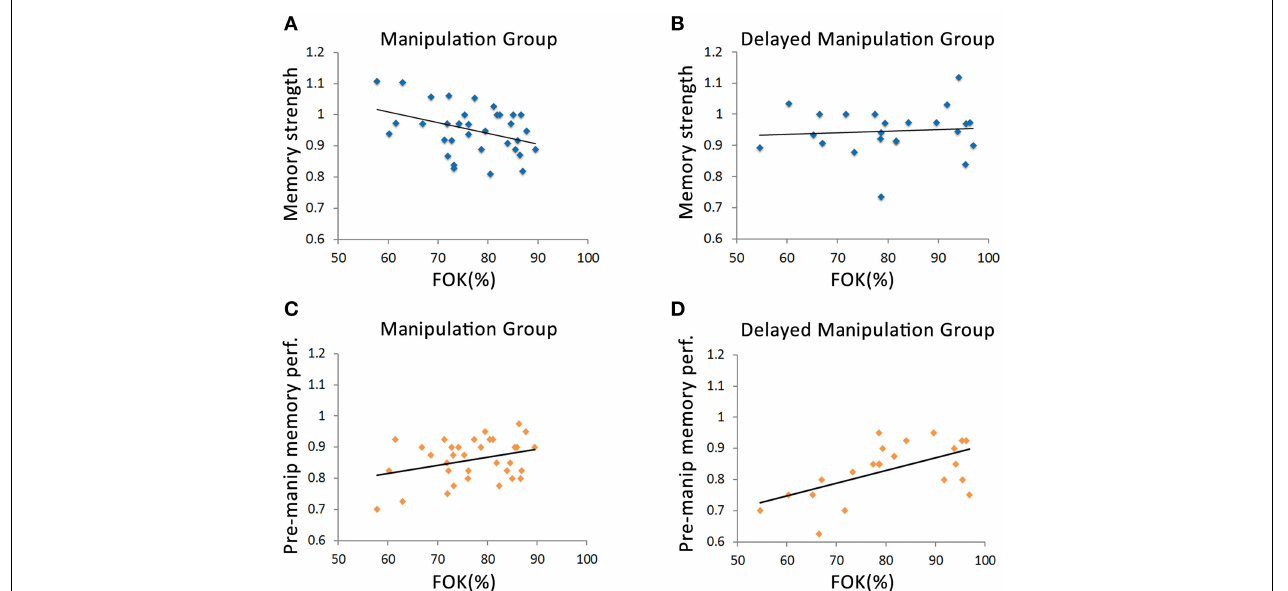
FIGURE 3 | Inter-participant correlations between FOK and Memory performance. (A) Scatterplot of memory strength vs. FOK for Manipulation Group, where movie 2 was learned immediately after reactivation of movie 1. The plot indicates a negative correlation between FOK and memory strength ( r = − 0 . 38, p < 0 . 05). (B) Scatterplot of memory strength vs. FOK for the Delayed Manipulation Group, for which movie 2 was learned 1 day after reactivation of movie 1, demonstrating that memory strength is not correlated with FOK levels ( r = 0 . 09, p = 0 . 69). The correlation slopes